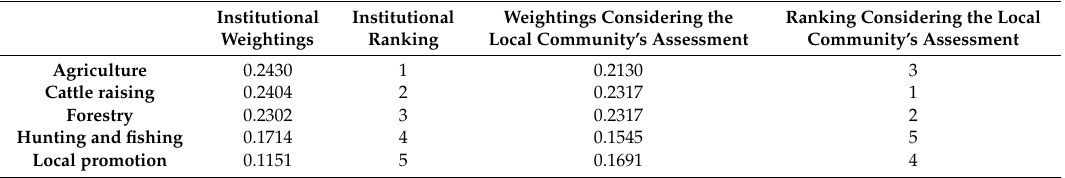
Table 4. Weightings and institutional ranking; weightings and ranking considering the local community’s assessments of the development